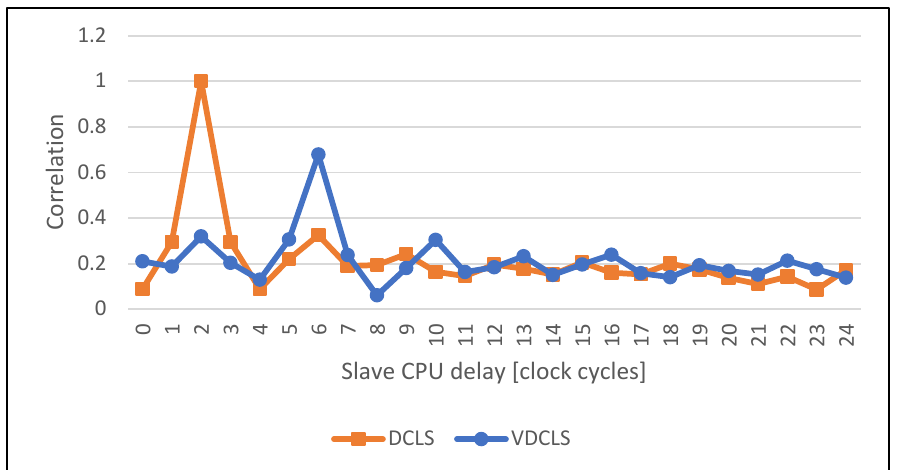
Figure 11. Comparison of the execution correlation between master and slave CPUs using VDCLS and legacy DCLS technique while executing the HMAC-SHA algorithm.